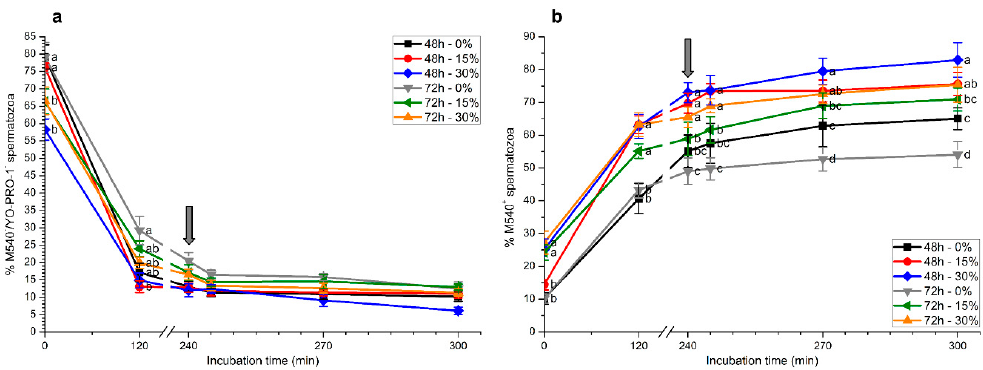
Figure 4. Percentages of viable spermatozoa with low membrane lipid disorder (M540 − / YO-PRO-1 − ; ( a )) and of M540 + spermatozoa ( b ) during in vitro capacitation and progesterone-induced acrosomal exocytosis (300 min) after previous storage of spermatozoa at 17 ◦ C with di ff erent concentrations of seminal plasma (0%, 15%, and 30%) for 48 h or 72 h. Grey arrow indicates the time at which 10 µ g / mL progesterone was added to induce acrosomal exocytosis (i.e., 240 min). Di ff erent letters mean significant ( p < 0.05) di ff erences between treatments at a given time point. Data are shown as mean ± SEM